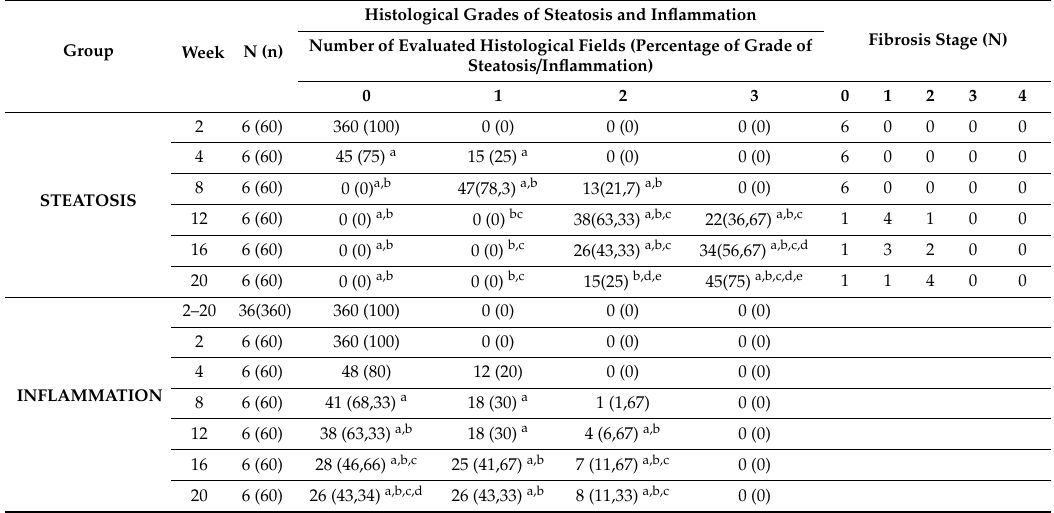
Fibrosis Stage (N)Number of Evaluated Histological Fields (Percentage of Grade of